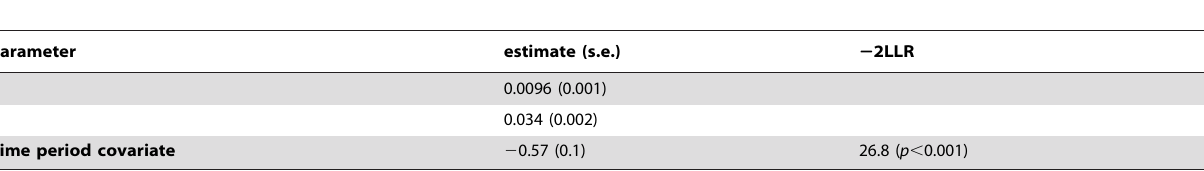
Table 1. Maximum likelihood estimates (with standard errors) of the Gompertz parameters and the effect of the time period covariate on mortality (with likelihood ratio test).